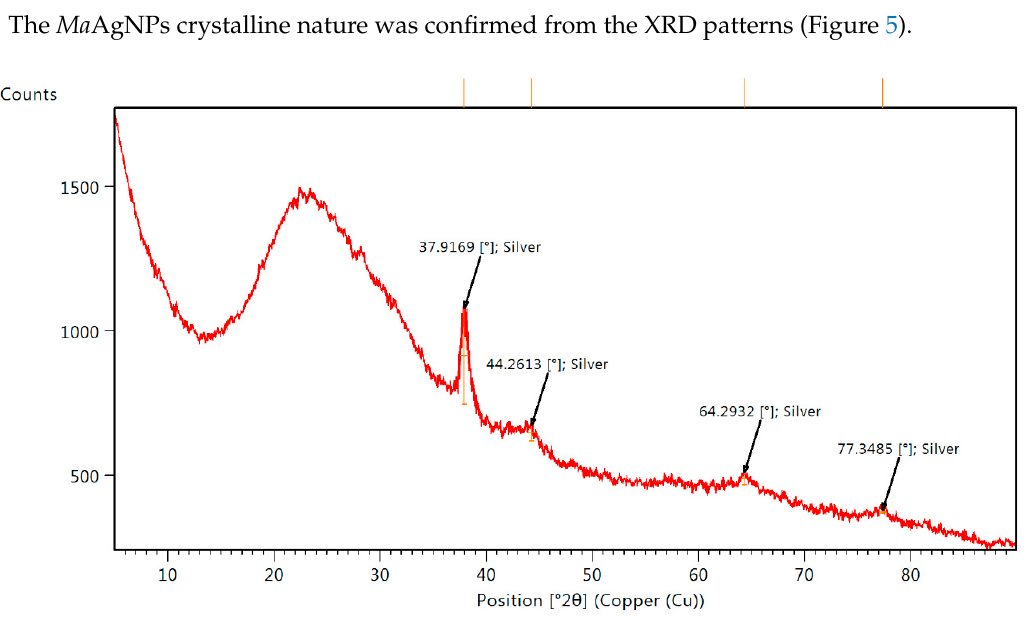
Figure 5. X-ray di ff raction (XRD) pattern of Ma Figure 5. X ‐ ray diffraction (XRD) pattern of Ma AgNPs. Figure 5. X ‐ ray diffraction (XRD) pattern of Ma AgNPs.